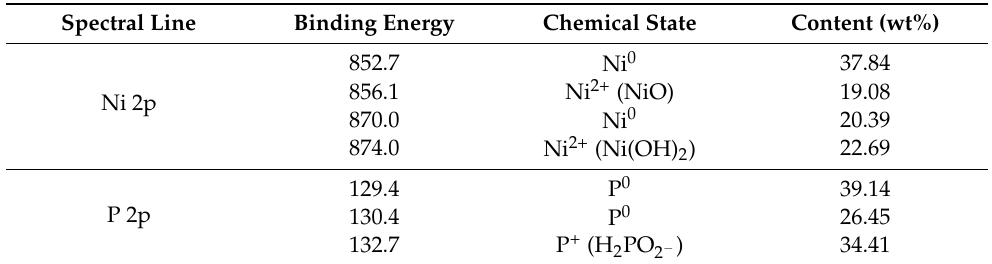
Table 1. Calibration results of Ni and P peaks on the surface of the ground-state alloy coating. Spectral